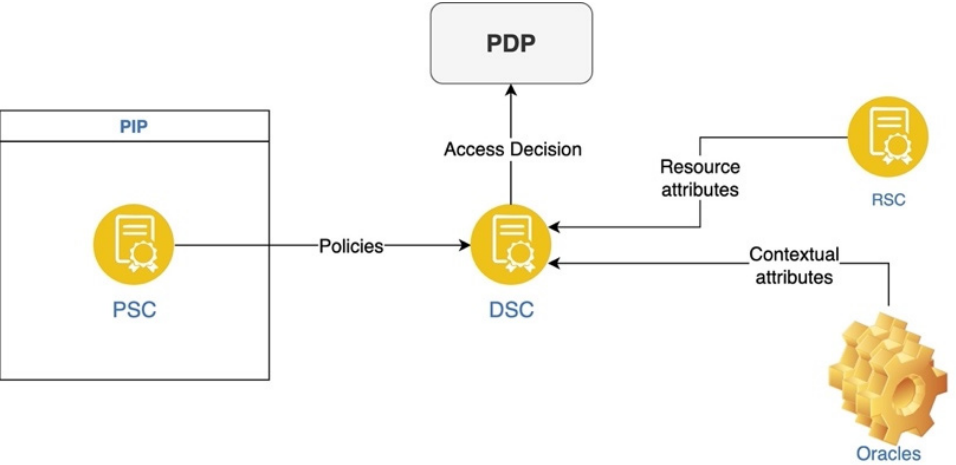
Figure 3. Interaction between the three types of smart contracts and the oracles.